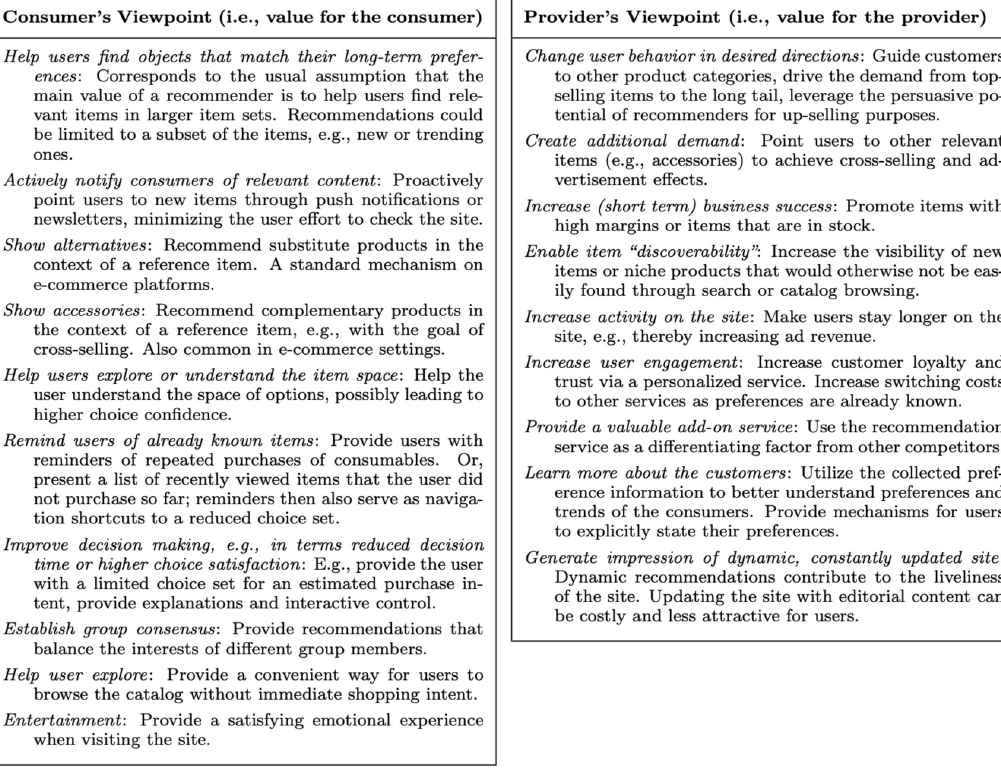
Figure 2: Examples for purposes for recommender systems (from Jannach & Adomavicius,